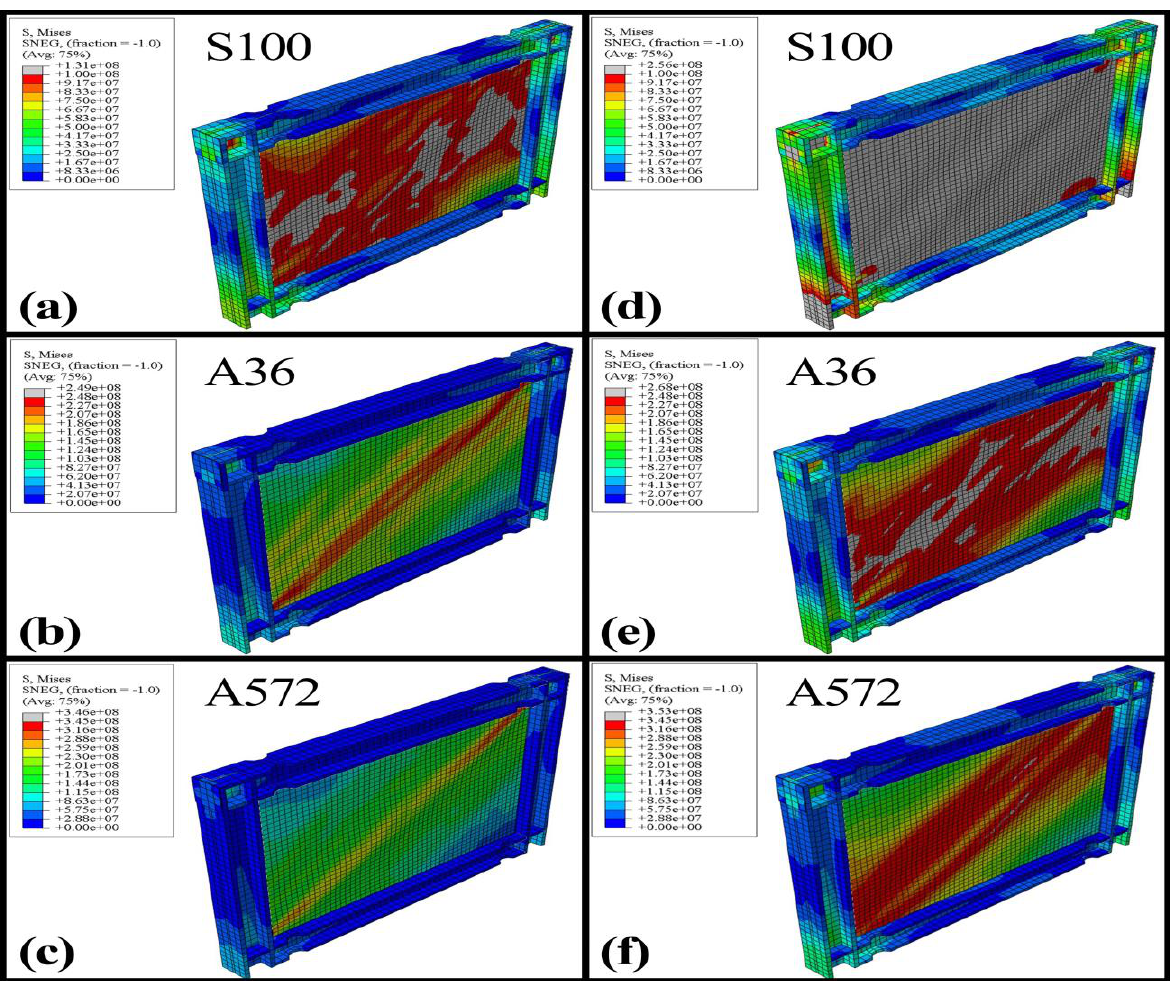
Fig. 6 . Von Mises stress distribution: (a) SPSW with low-yield infill steel plate at drift of 0.33% (b) SPSW with low-yield infill steel plate at drift of 1% (c) SPSW with medium-yield infill steel plate at drift of 0.33% (d) SPSW with medium-yield infill steel plate at drift of 1% (c) SPSW with high-strength infill steel plate at drift of 0.33% (f) SPSW high-strength infill steel plate at drift of